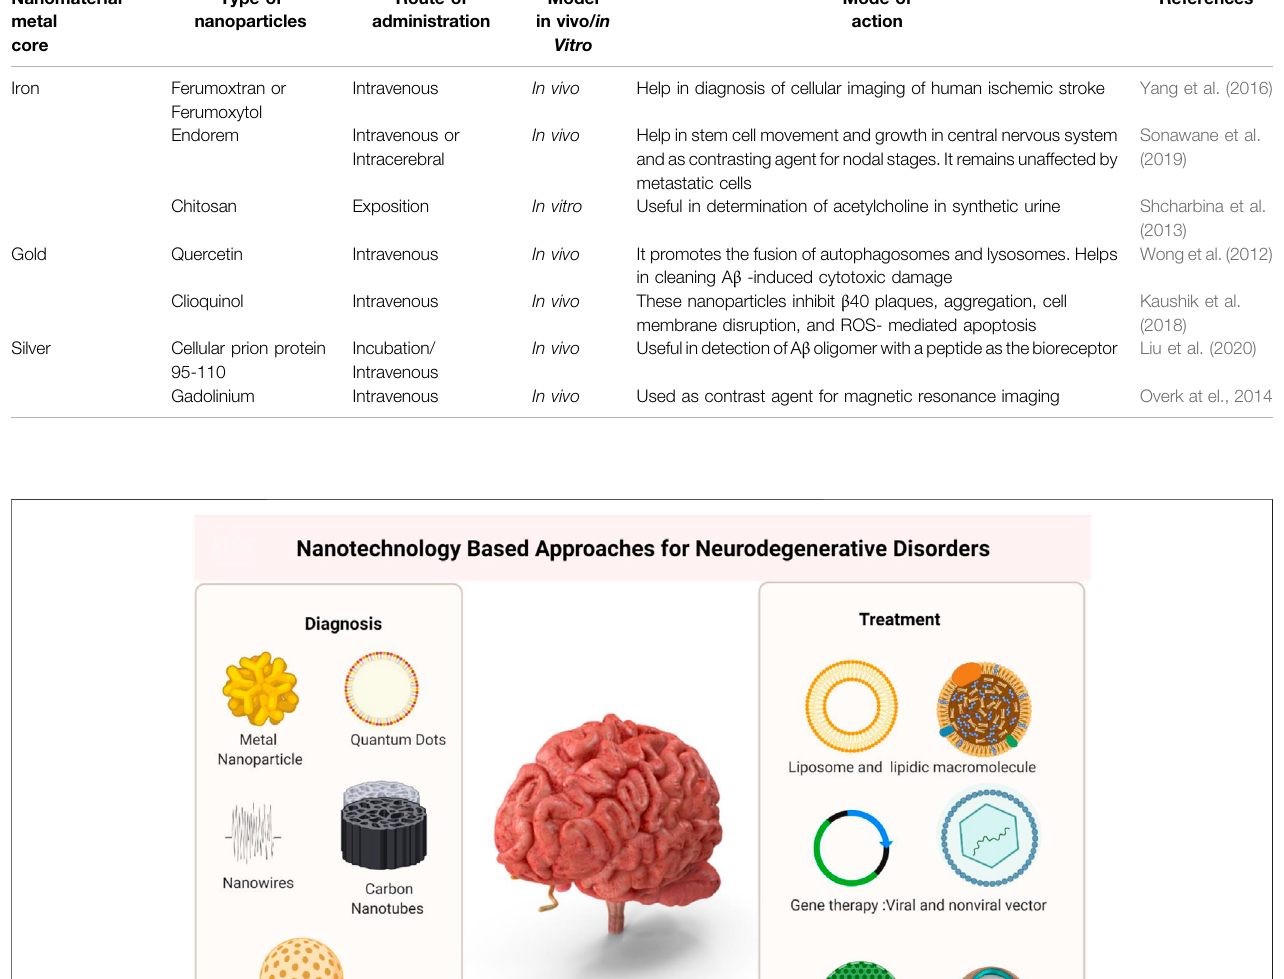
Frontiers in Bioengineering and Biotechnology |